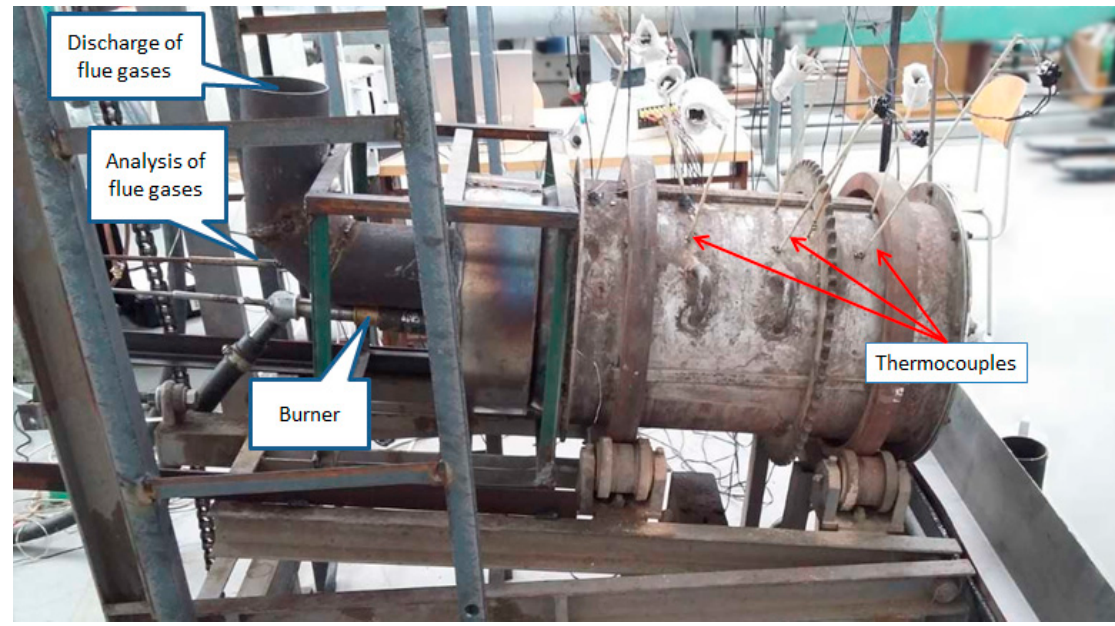
Figure 1. Experimental model of the tilting rotary furnace.